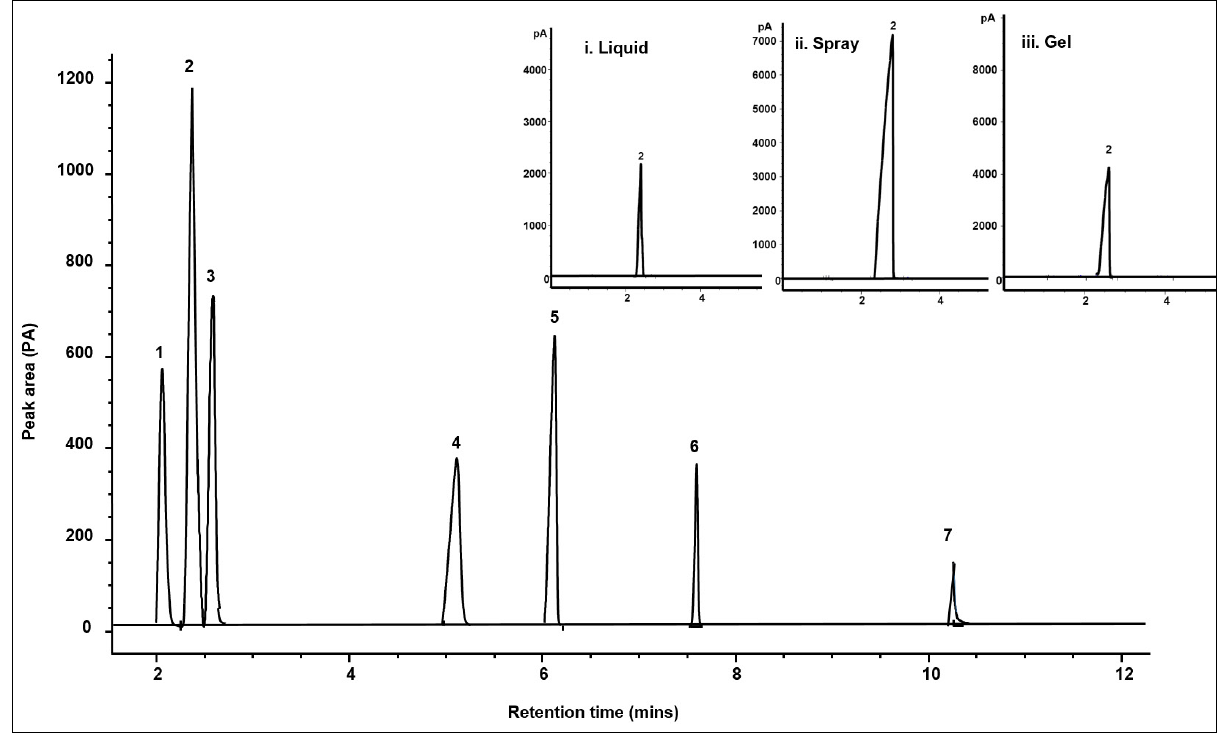
Figure 1: Separation of a mixture of seven alcohols – methanol (1), ethanol (2), isopropanol (3), pentanol (4), isobutanol (5), butanol (6) and octanol (7) – in less than 11 min on a 25-m Agilent HP-INNOwax polyethylene glycol capillary column. Inserts: Representative chromatograms of (i) liquid-, (ii) spray- and (iii) gel-based alcohol-based hand